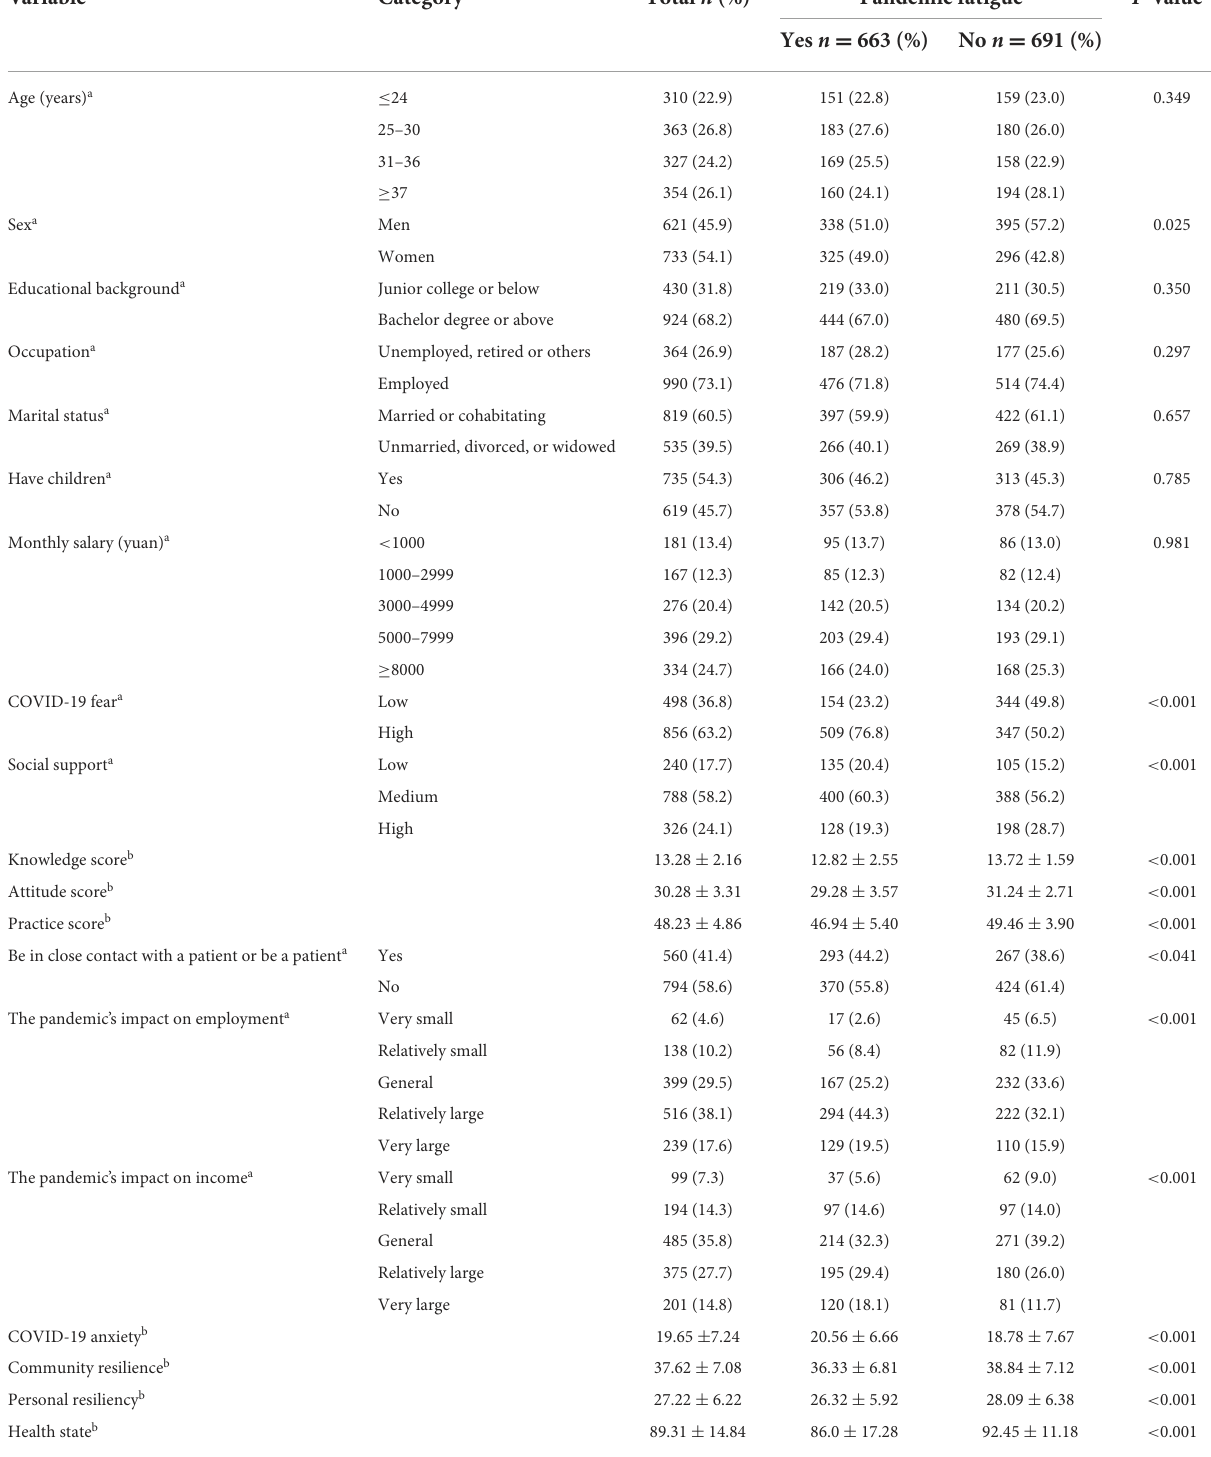
TABLE 1 Characteristics of questionnaire respondents and univariate analysis